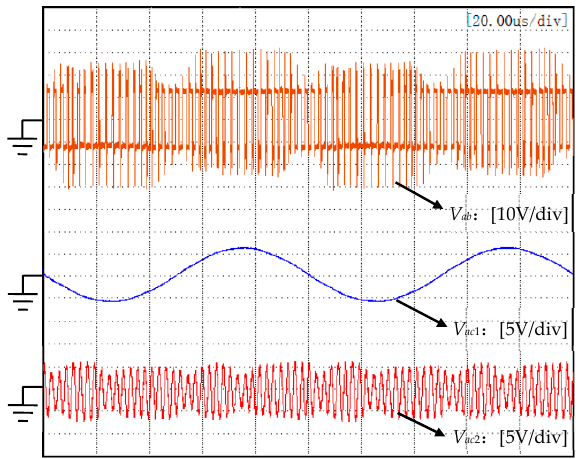
Figure 9. Experimental waveforms at V ac 1 = V ac 2 = 0.6 (normalized), V dc = 10 V and k = 37. (Full-bridge voltage V ab , fundamental frequency load voltage V ac 1 , and high-frequency load voltage V ac 2 ). Energies 2020 , 13 , x FOR PEER REVIEW